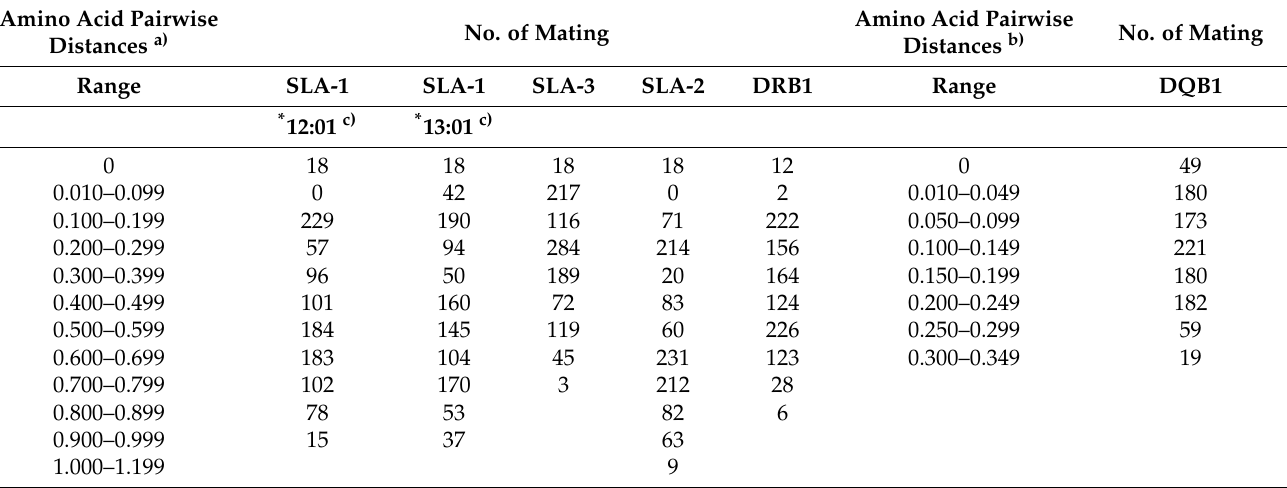
Table 2. Number of matings in each range classified by the sum of the amino acid pairwise distances of SLA class I and class II alleles between mating pairs for correlation analyses among farrowing rates and the amino acid pairwise